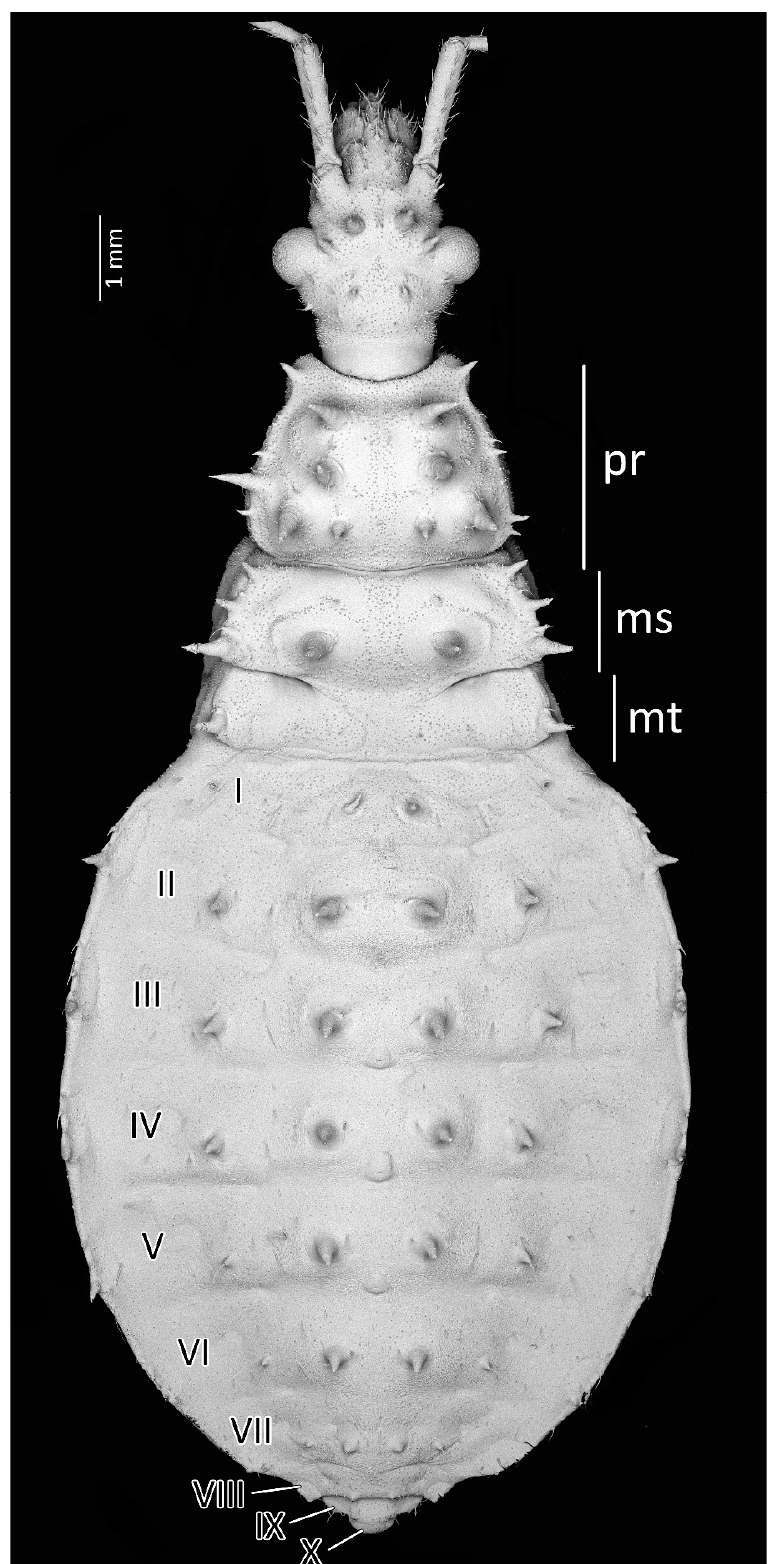
Figure 9. ( A ) Dorsal and ( B ) ventral habitus of the third instar of Psyttala horrida (Stål, 1865).